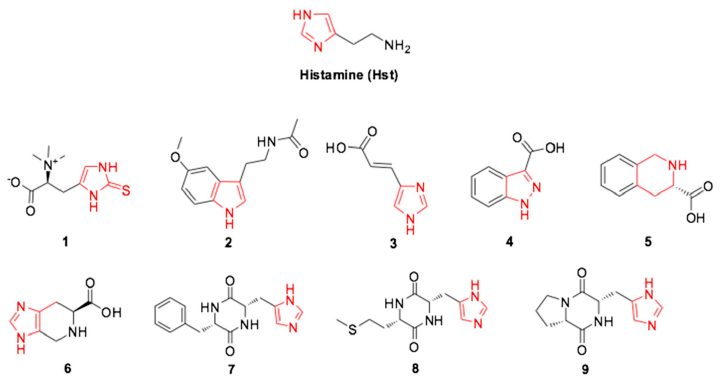
Figure 1. Chemical structures of histamine (Hst, reference drug), commercial products 1 – 6 , and synthetic compounds 7 – 9 .